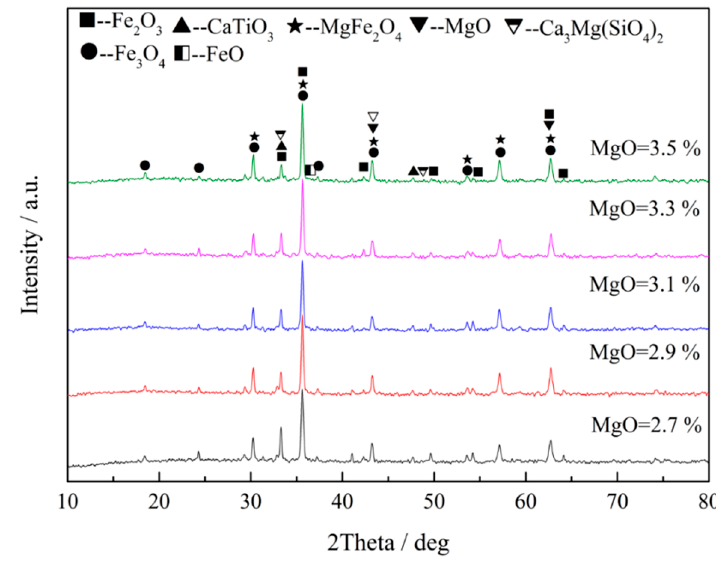
Figure 4. XRD pattern of HCVTM with different mass-% MgO.